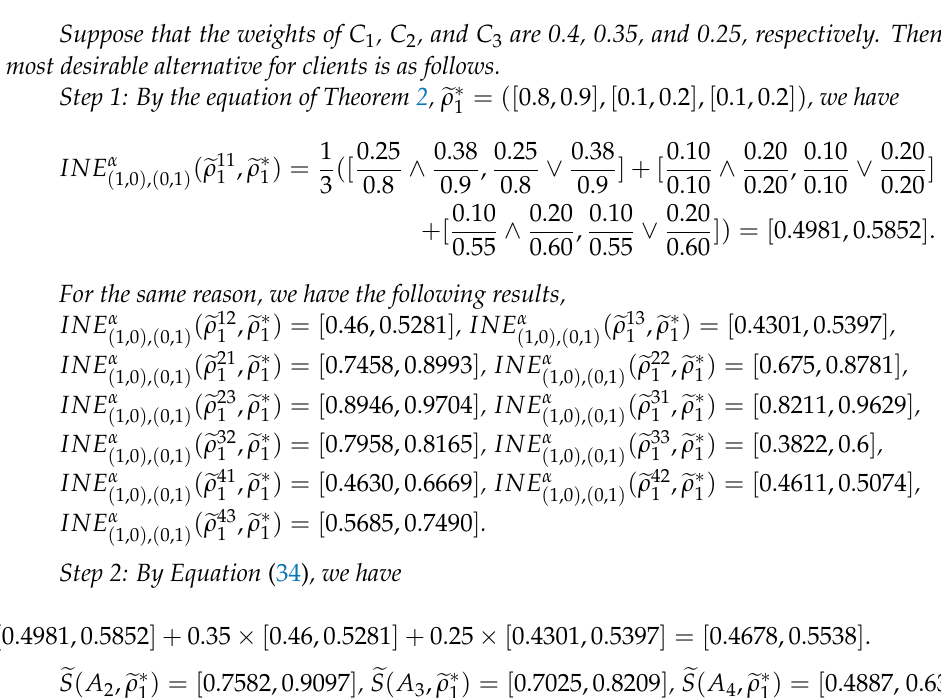
Figure 3. The visualization of the truth-membership interval of edge servers compared with the reference interval of three